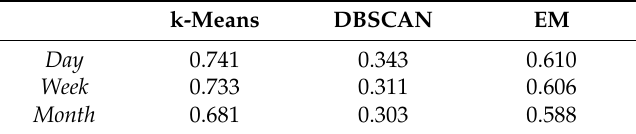
Table 2. Silhouette Coefficient evaluation results upon the selected clustering